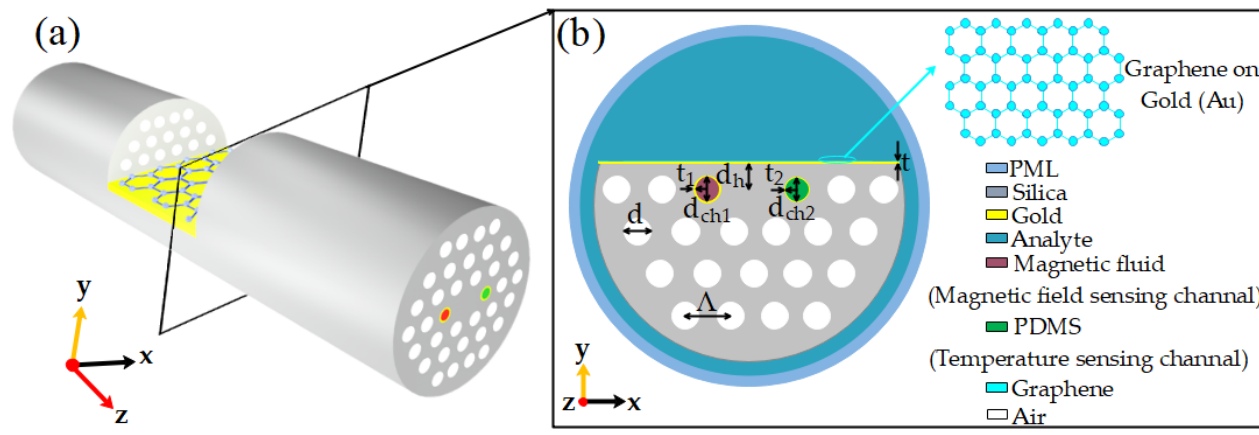
Figure 1. Schematic diagram of a plasmonic optical fiber sensor: ( a ) its three-dimensional structure; ( b ) its two-dimensional cross-section structure.